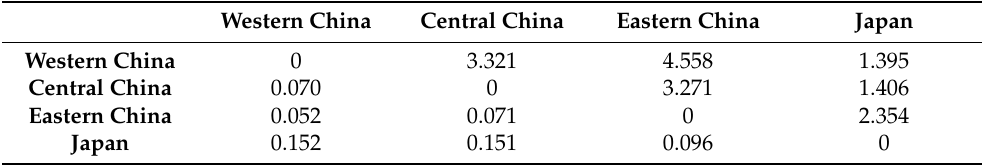
Table 4. Genetic differentiation of C. camphora across four regions (lower diagonal: pairwise F ST ; upper diagonal: pairwise N